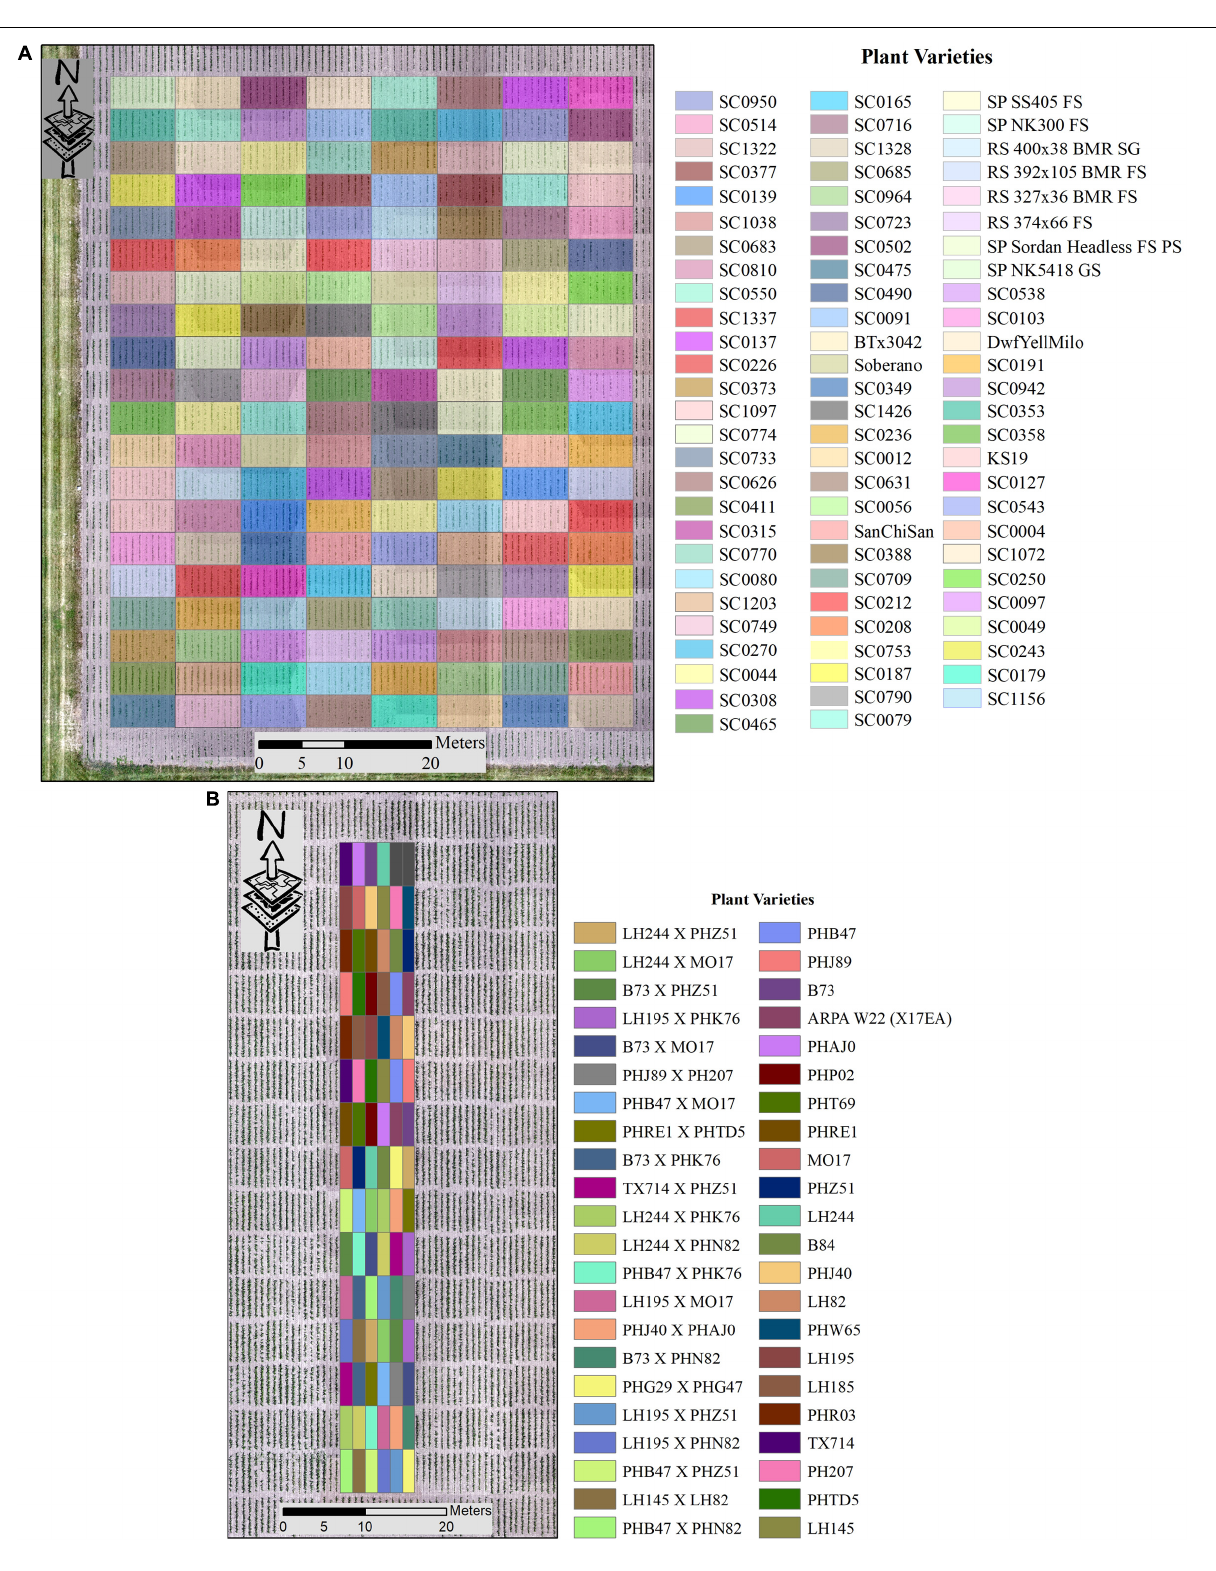
Frontiers in Plant Science |